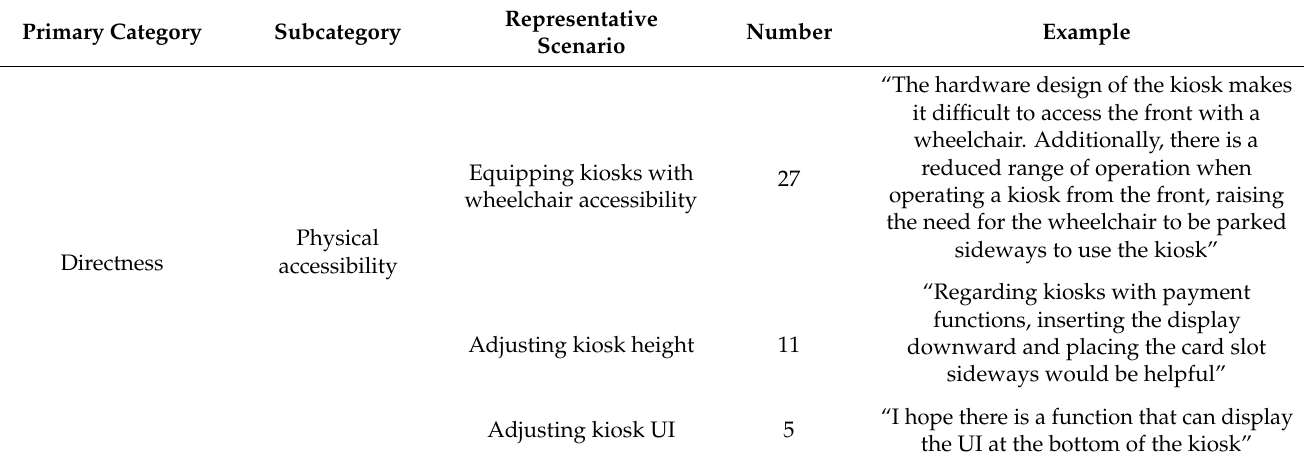
Table 5. Accessibility items for participants with physical